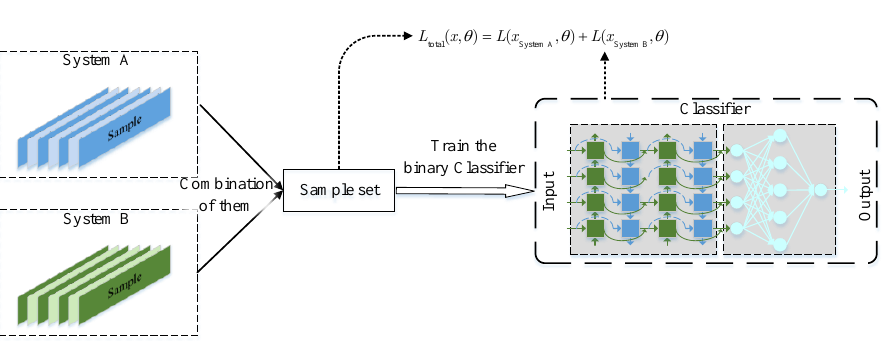
Figure 4. One-step training strategy for FLS model.